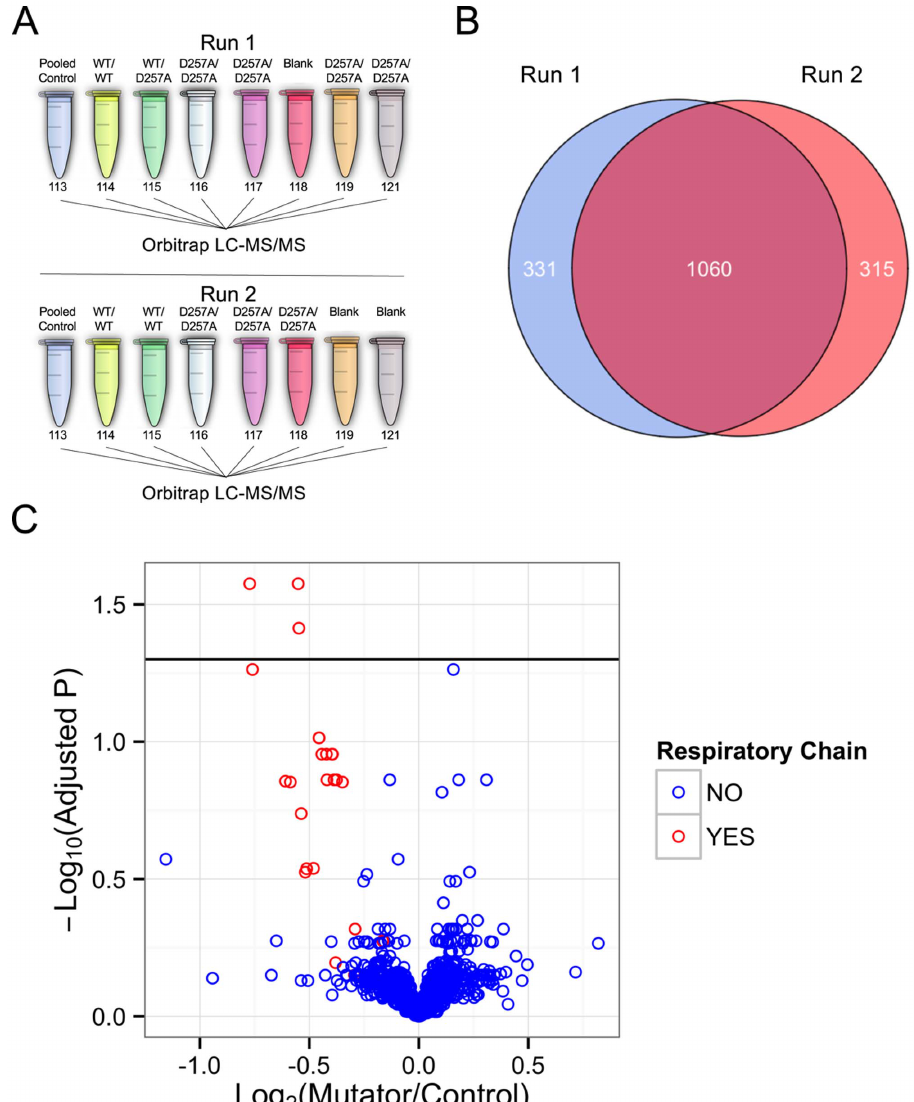
Figure 1. Proteomic analysis of the Polg mutator mouse brain. A) Schematic of iTRAQ labeling and LC-MS/MS experiment. A pool of the four control (3 WT/WT and 1 WT/D257A) brains was used as a reference in both LC-MS/MS runs and allowed for cross-run comparison. B) Venn diagram displaying the total number of proteins identified and quantified in each LC-MS/MS run. C) Volcano plot of the 1060 proteins quantified in both LC- MS/MS runs (n=4 Control, n=7 Mutator, Welch T-test p values adjusted using Benjamini-Hochberg method to control FDR). Data points are colored by membership in the Uniprot ‘‘Respiratory Chain’’ gene ontology group. The horizontal line shows the preset p value cutoff for statistical significance (FDR adjusted p ,